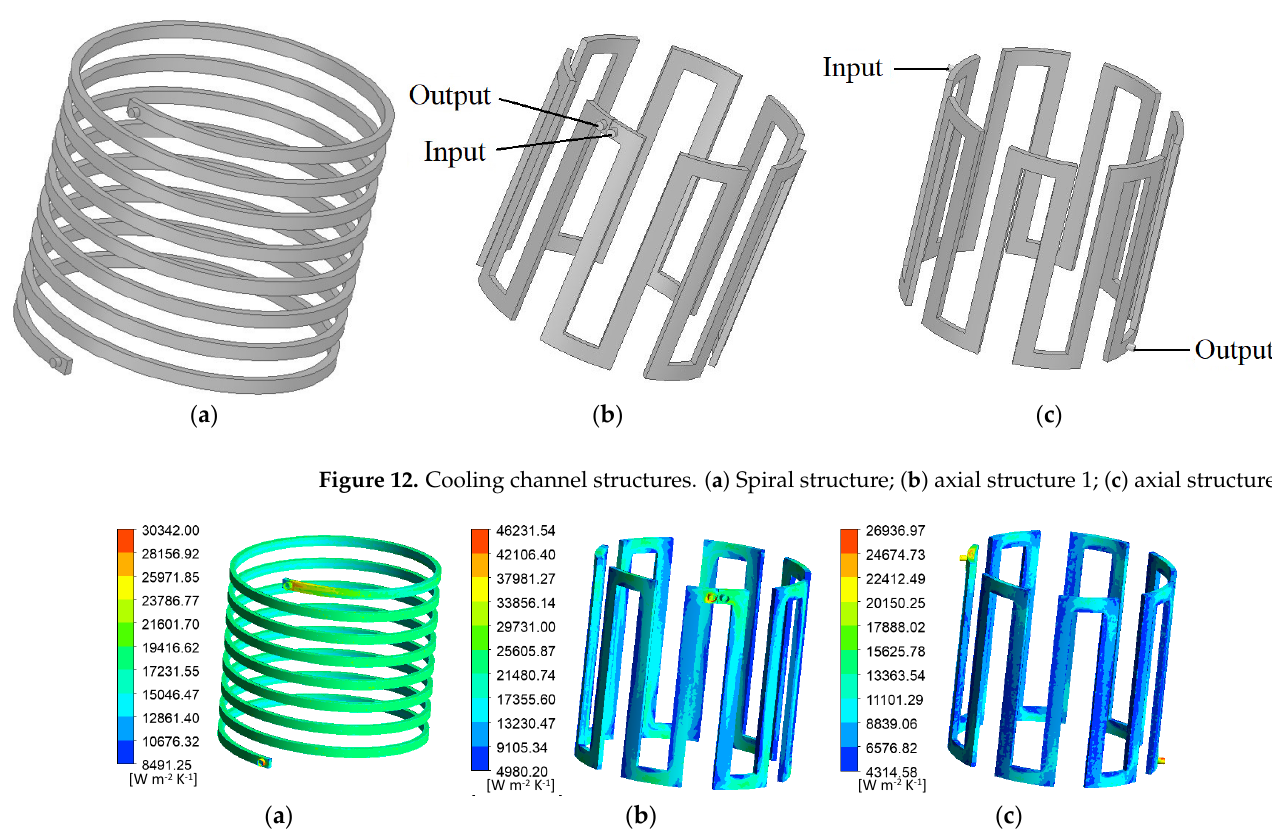
Figure 13. Heat transfer coefficient distribution of the three cooling channel structures. ( a ) Spiral structure; ( b ) axial structure 1; ( c ) axial structure 2. Table 7. The maximum temperature of each part of motors with different cooling channel structures.